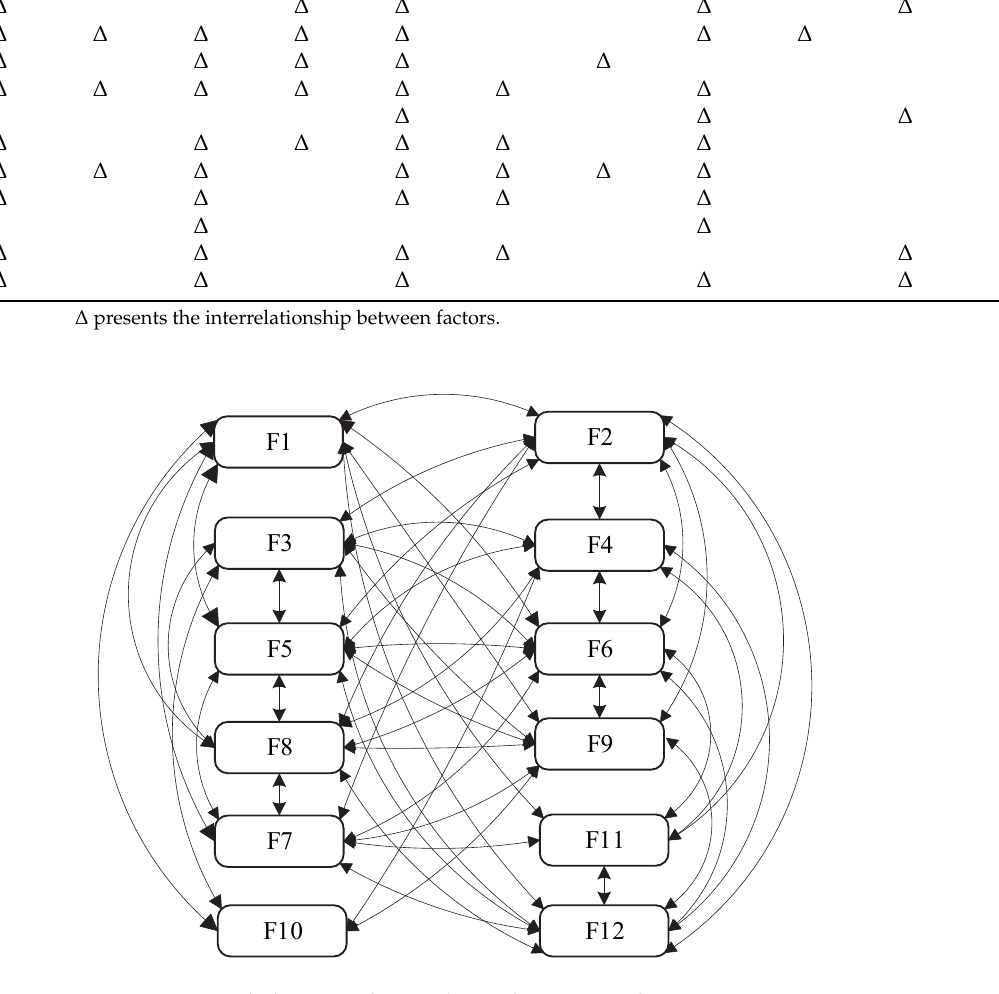
Figure 3. Network diagram of interrelationships among factors. Table 13. Interaction matrix of factors.